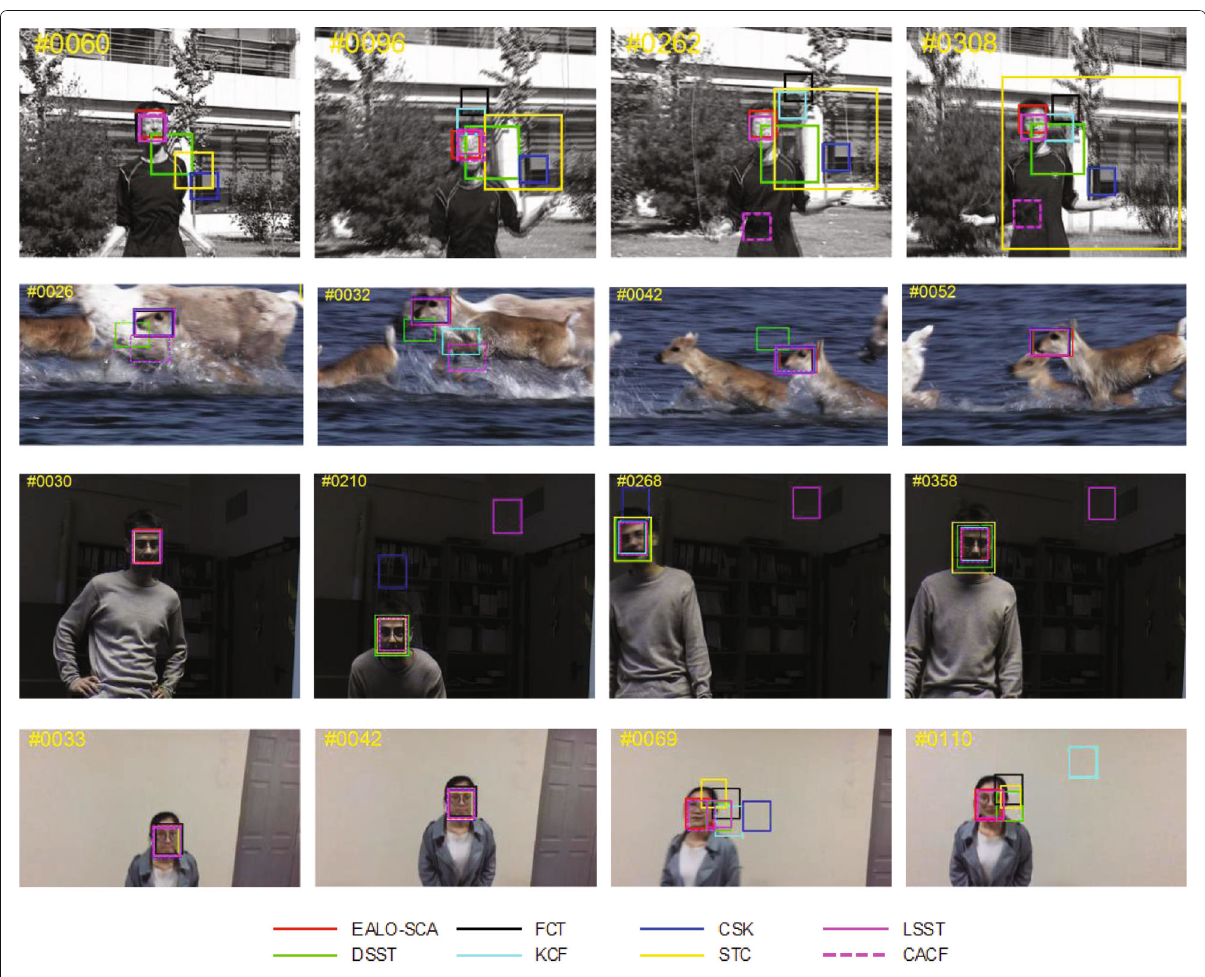
Fig. 11 The tracking results with the middle motion. Sequence 1-4: JUMPING, DEER, FACE1, ZXJ